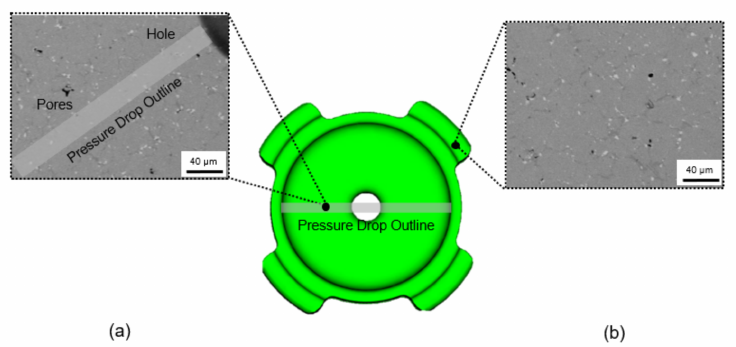
Figure 5. SEM images for ( a ) region with pressure drop and ( b ) low quality